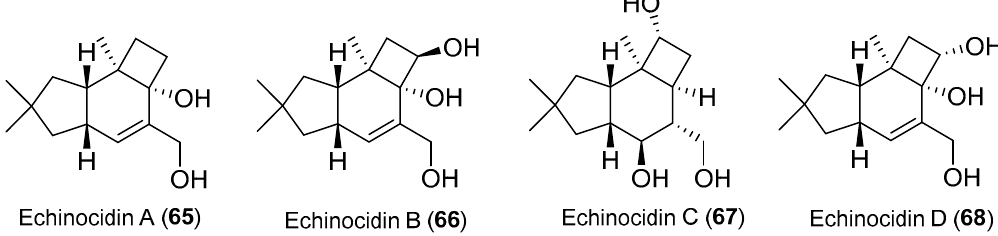
Figure 13. Structures of echinocidins A–D ( 65 – 68 ) from Echinodontium